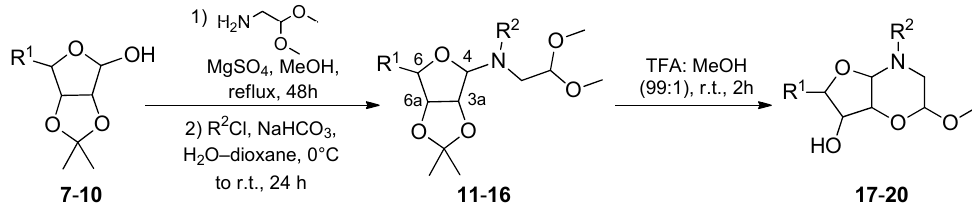
Table 1. Structures and yields of hexahydro-2 H -furo[3,2- b ][1,4]oxazine compounds